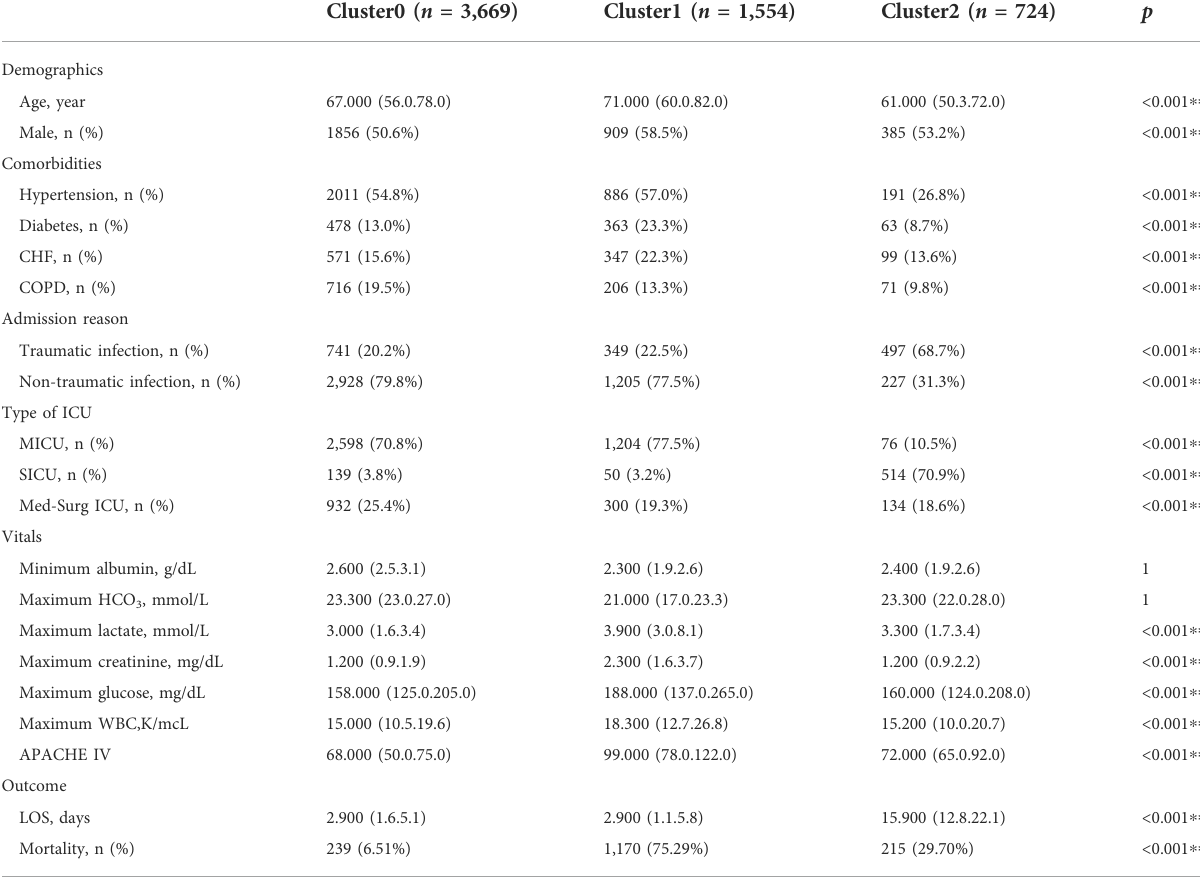
TABLE 4 Clinical characteristics and outcomes of three phenotypes in the eICU derivation